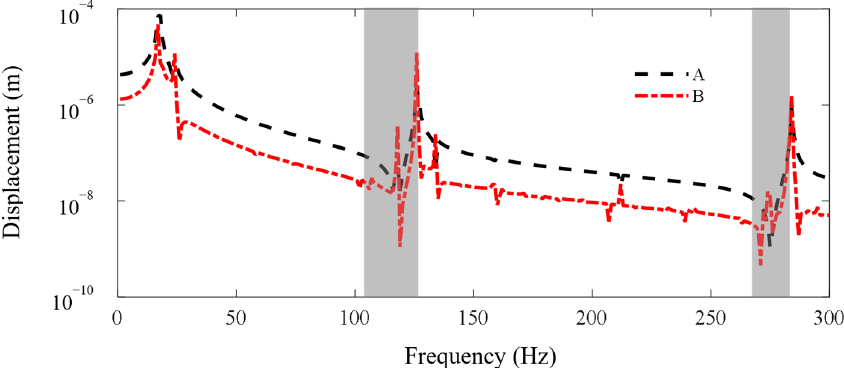
Figure 7. The FRF curves of the metamaterial plate at points A and B of the cover plate along the y axis. The dotted line and the dash-dotted line denote the FRF curves of points A and B.